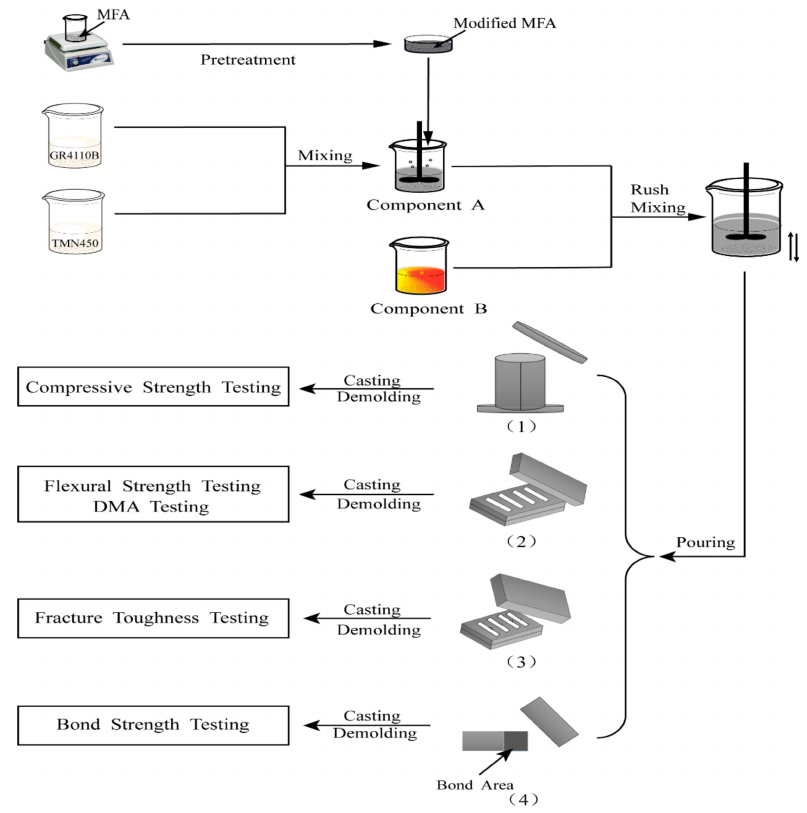
Figure 1. Schematic diagram of PU / MFA composites